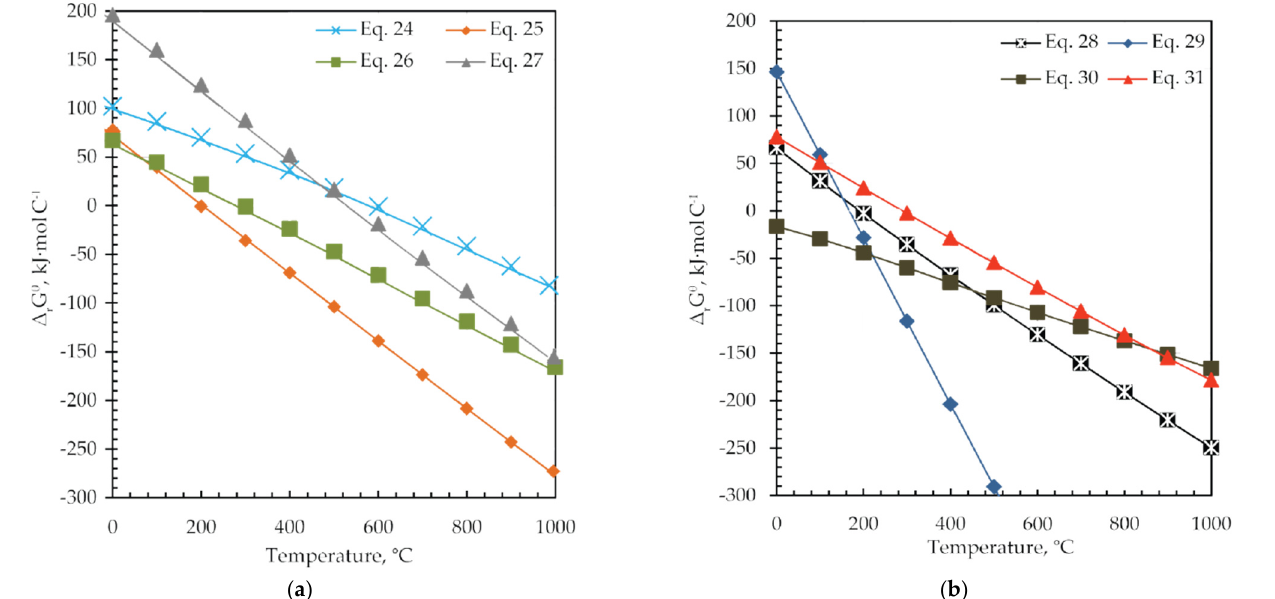
Figure 11. The change in standard Gibbs free energy ( Δ r G θ ) versus temperature for ( a ) Equations (24)–(27) and ( b ) Equations (28)–(31).